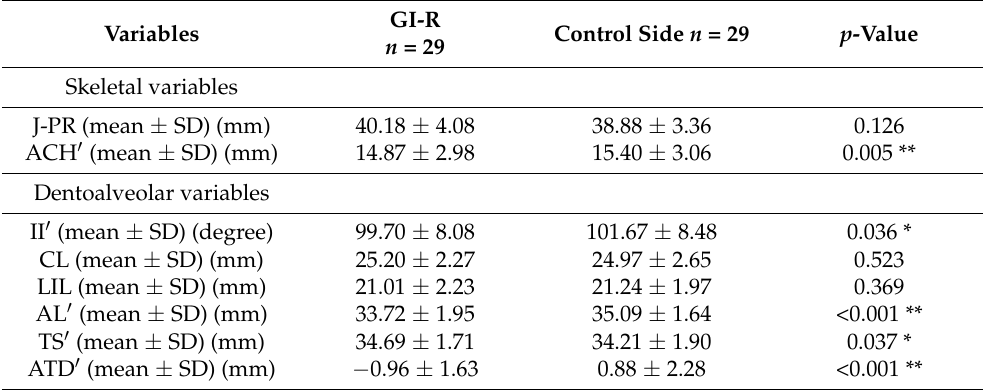
Table 4. Comparisons according to the right side (GR) vs. control side (GC ´ ) of impaction of the skeletal and dentoalveolar variables ( n = 29).